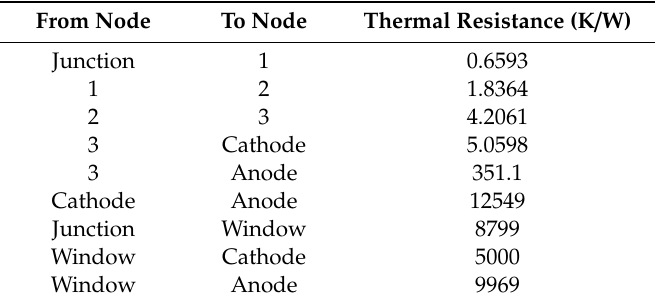
Table 2. CTM thermal resistance values.